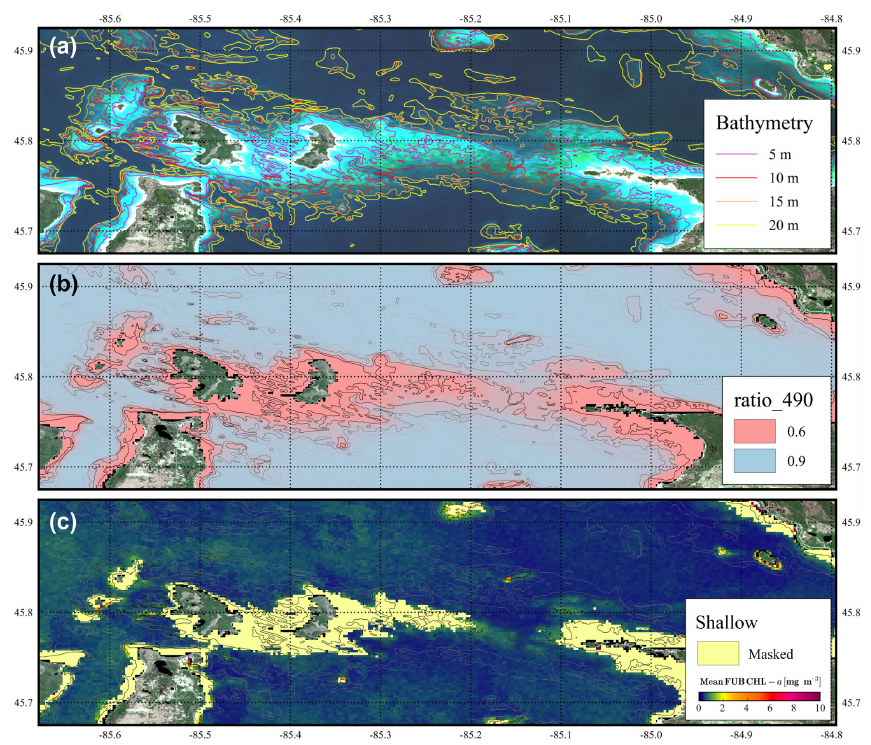
Figure 3. Shallow water flagging for the Beaver Island Archipelago in the north of Lake Michigan. (a) Sentinel-2A true colour image, 8 May 2017. (b) Ratio_490 from MERIS data, acquired in May–October 2008. (c) Shallow water mask for ratio_490 with a threshold of 0.65 on top of the chl layer for October 2011 as contained in product layer shallow . Bathymetry data provided by NOAA-NCEI. Table 1. Input, output and aggregation specifications for the monthly